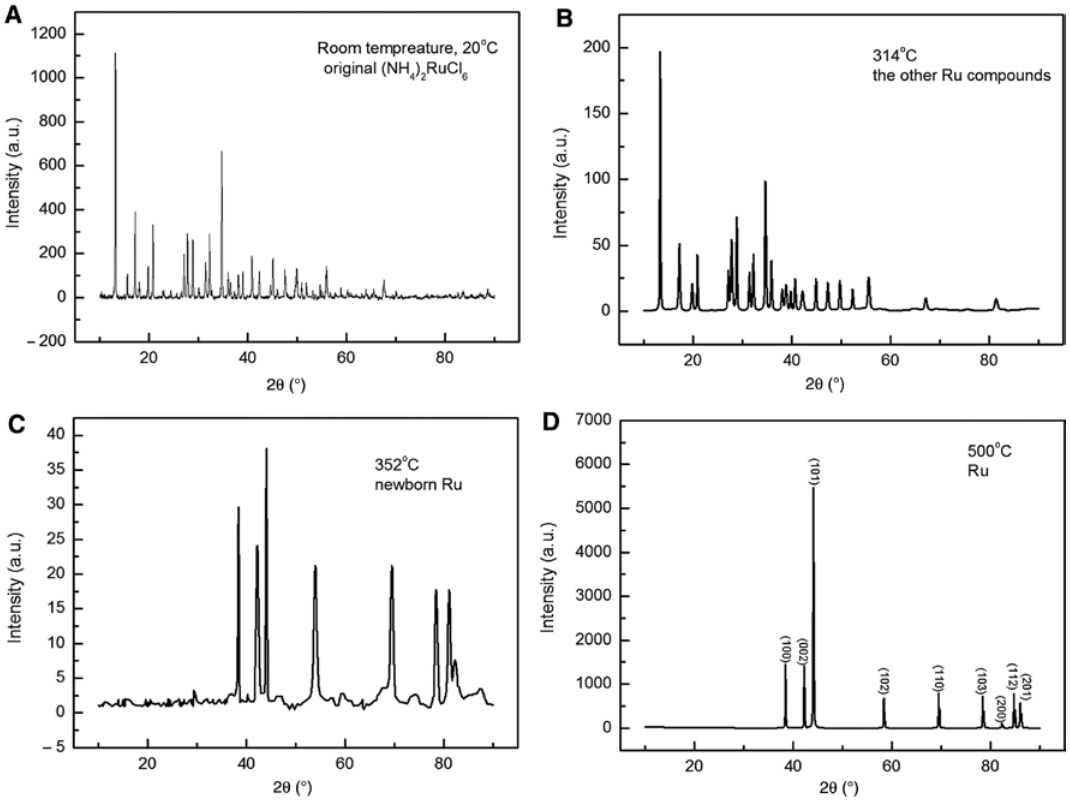
) RuCl powder and their different thermal decomposition products. 4 2 6